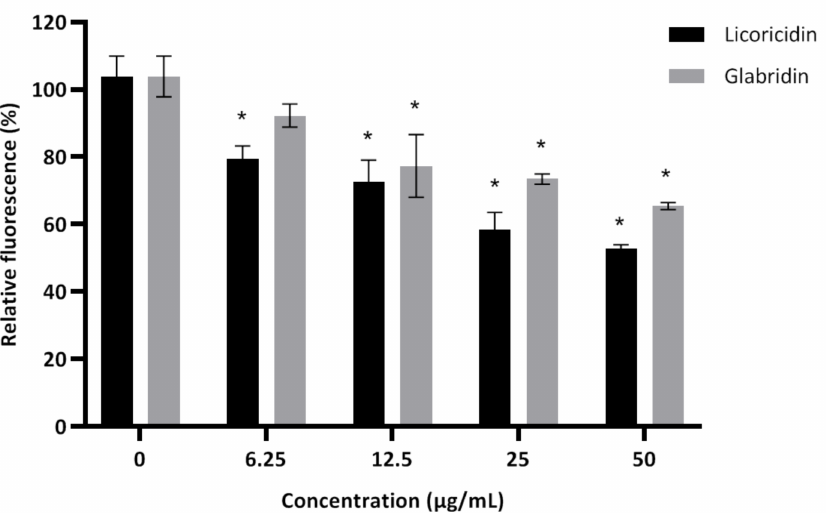
Figure 3. Effect of licoricidin and glabridin on the adherence of fluorescein isothiocyanate (FITC)- labeled Streptococcus mutans ATCC 25175 cells to a saliva-coated hydroxylapatite surface. The number of adhered bacteria was assessed by determining the relative fluorescence units (excitation wavelength 495 nm; emission wavelength 525 nm). The assays were carried out in triplicate, and the means ± standard deviations were calculated. *, significantly different ( p < 0.001) from the control (no licorice